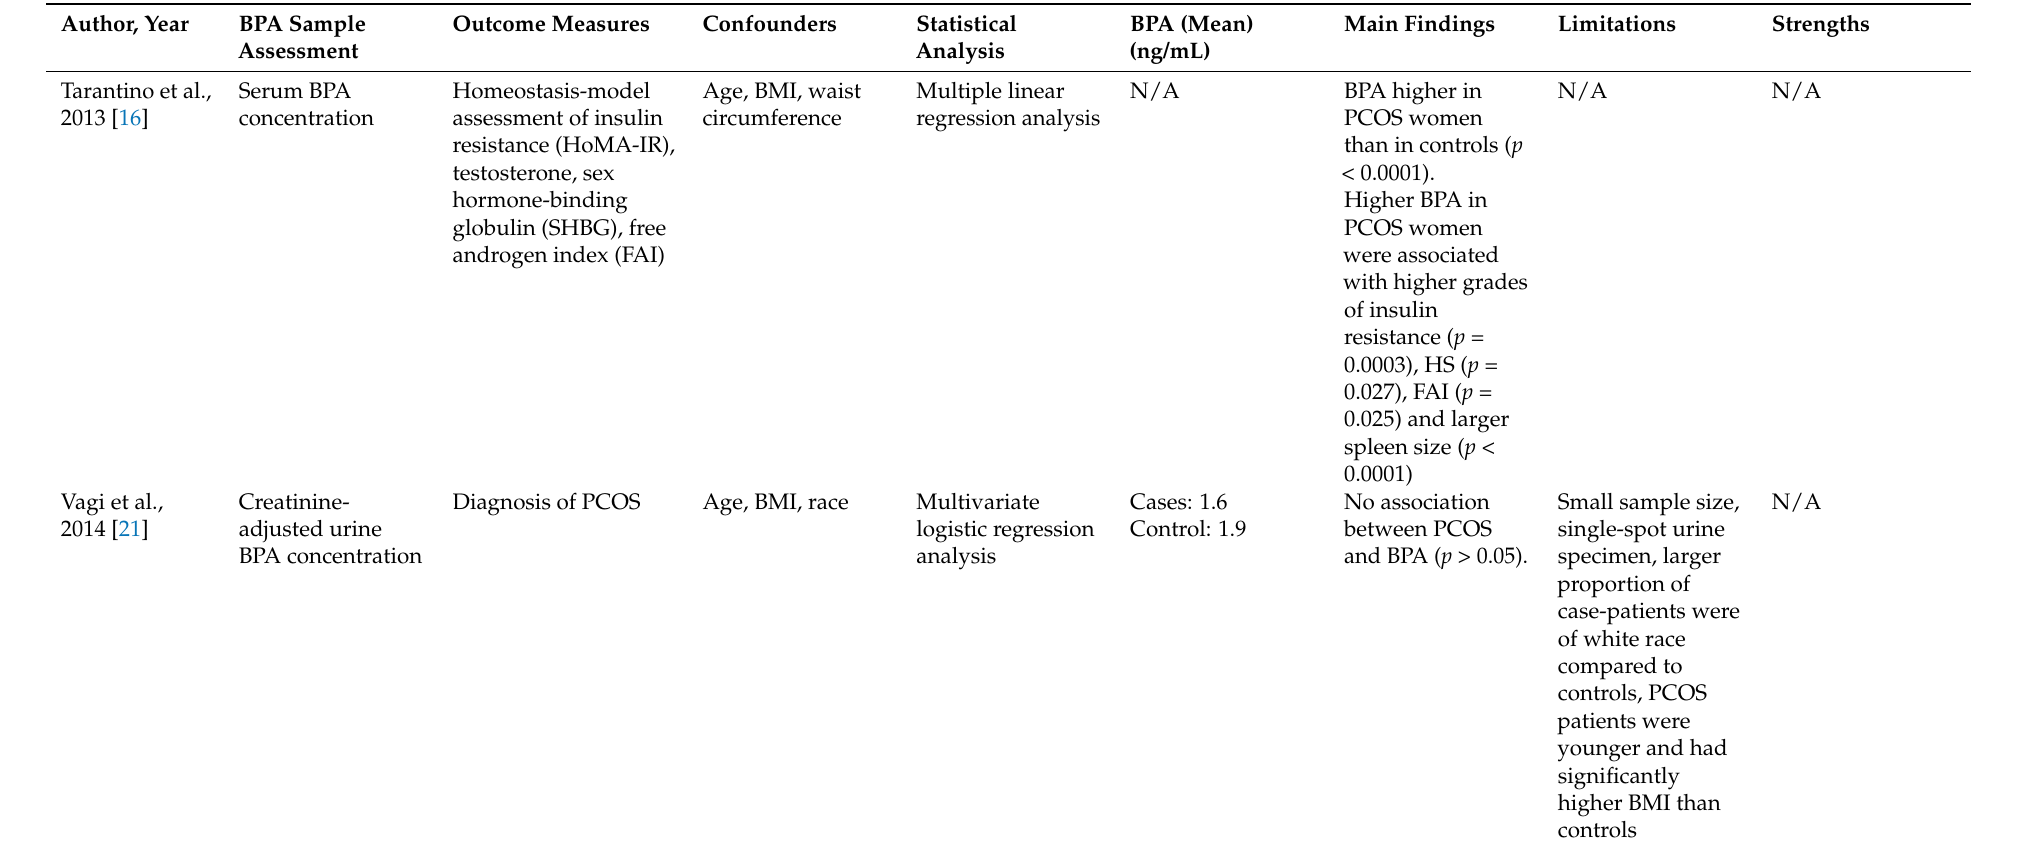
Table 3. Bisphenol-A (BPA) and polycystic ovary syndrome